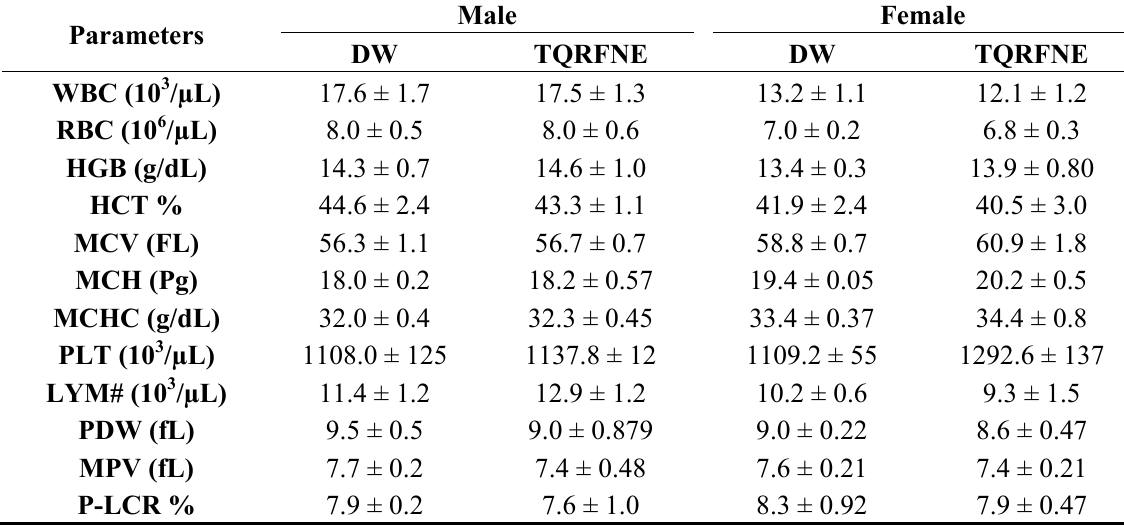
Table 2. Effects of oral administration of thymoquinone-rich fraction nanoemulsion (TQRFNE) and distilled water (DW) on hematological parameters of male and female rats